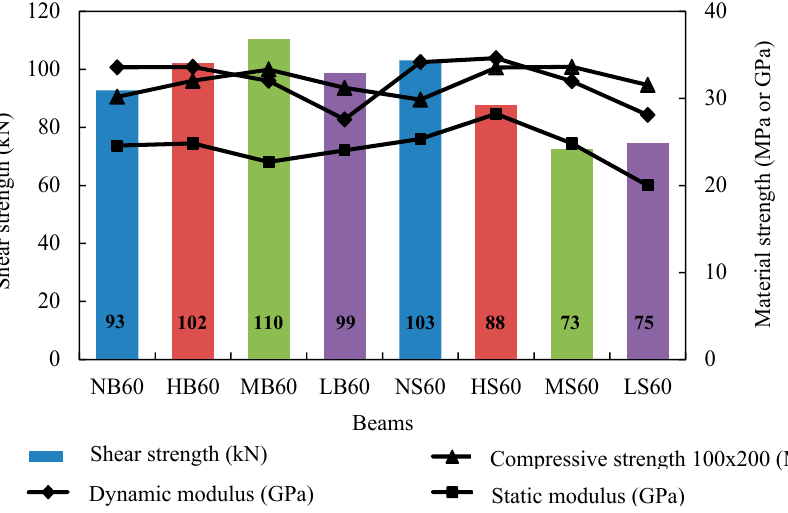
Figure 20. Shear strength of the RC beams and material properties of the